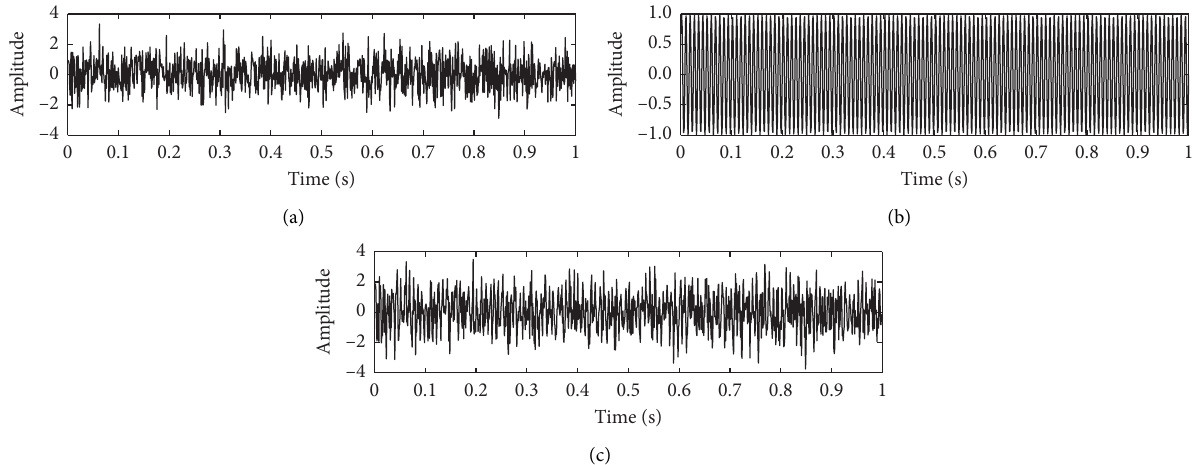
Figure 2: Waveform of the simulation signal. (a) Gaussian white noise with power of 0.2. (b) Sinusoidal steady-state signal with frequency 120Hz. (c) The simulation signal.